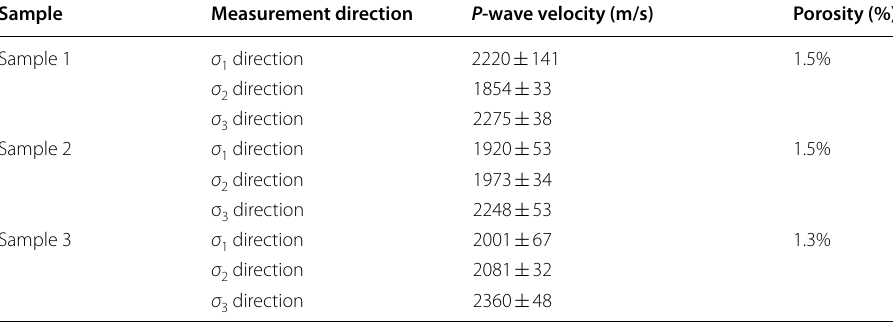
Table 1 P -wave velocities (average the porosities for each